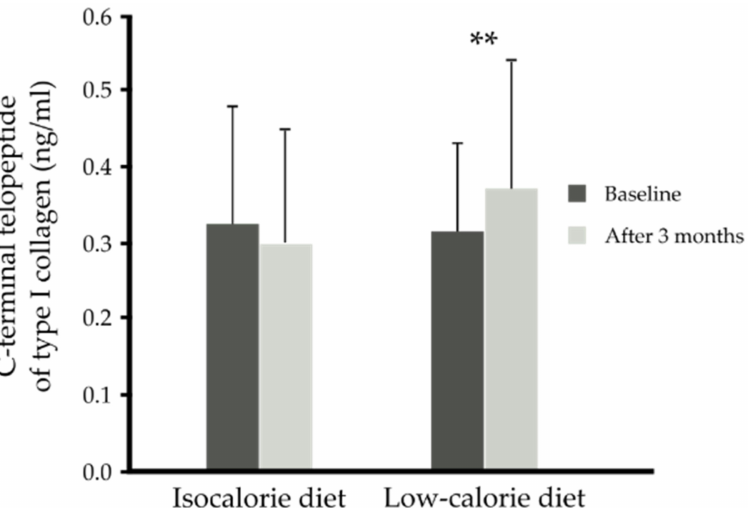
Figure 6. Serum C-terminal telopeptide of type I collagen (CTX-I) (ng/mL) before and after 3 months of isocaloric diet ( n = 27) intervention or before and after 3 months of low-calorie diet ( n = 37) intervention independent of supplementation. Data are shown as means ± SD. Statistics: analyses were performed with repeated measures by ANOVA and Tukey post hoc test; significance: ** p < 0.01 after versus before low-calorie diet.